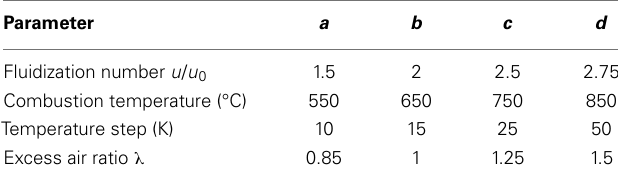
Table 6 | Parameters investigated for sensitivity analysis